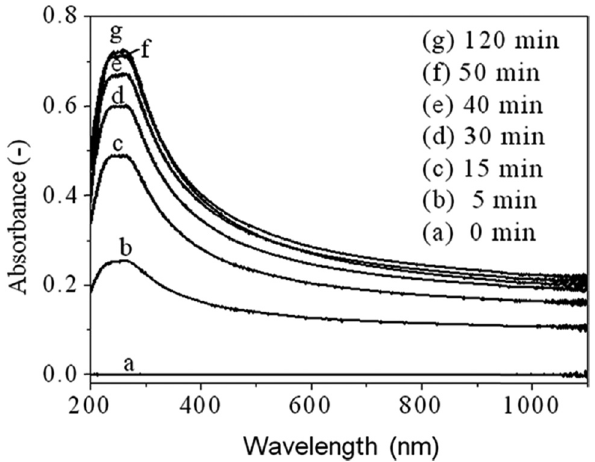
Figure 1: UV - Vis images of CNT suspensions under di ff erent ultra - sonic treatment durations [ 29 ]